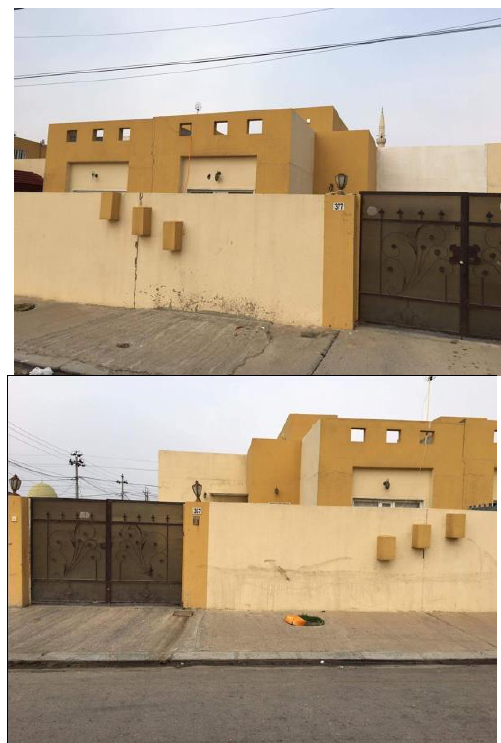
Figure 7. Aarshum Project. (By